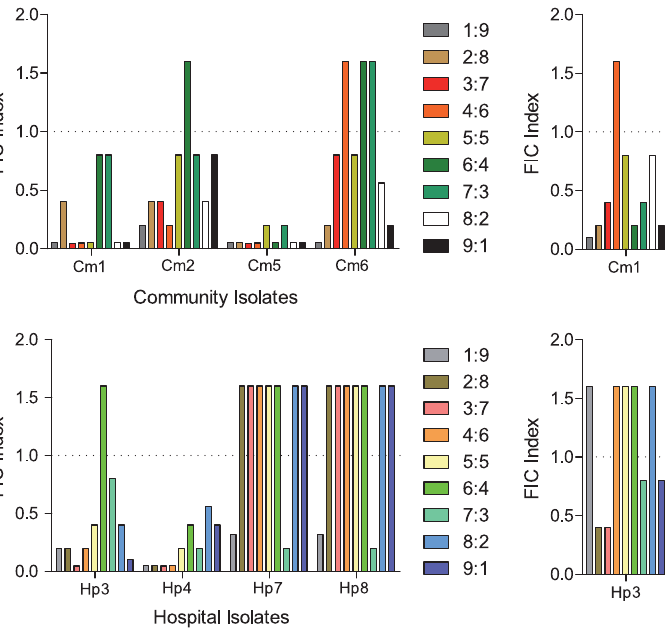
FIGURE 2. Susceptibility of ESBL Isolates to Gentamicin- Amoxicillin/Clavulanic acid antibiotics cocktail Varying proportions of Gentamicin and Amoxicillin/Clavulanic acid antibiotics ranging from 1:9 to 9:1 were mixed according to the continuous variation checkerboard method and seeded into Mueller Hinton agar. The ESBL producing organism was streaked on the surface of the agar plate. The set up was done in triplicate with a control containing no antibiotics and these were incubated at 37 o C for 24 hours and observed for growth. The MICs of the various combinations were determined and interactions between the antimicrobial agents were assessed by determining their Fractional Inhibitory Concentration [FIC] index ratios where FIC index value below unity signi fi es syn- ergism, ≥ 1 ; indifference, and ≥ 2; antagonism (Cm1, Cm2, Cm5, and Cm6 represent community isolates, while Hp3, Hp4, Hp7, and Hp8 represent hospital isolates